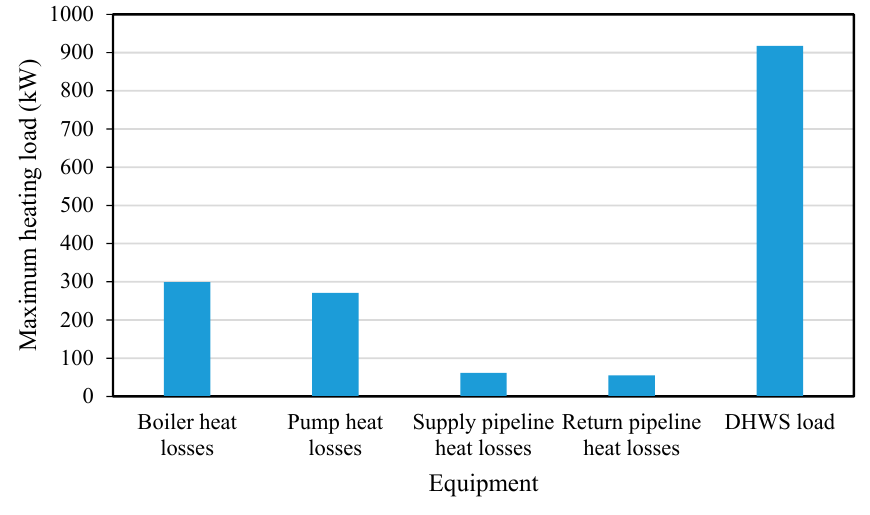
Figure 15. Bar chart of heat losses from the equipment [kW].